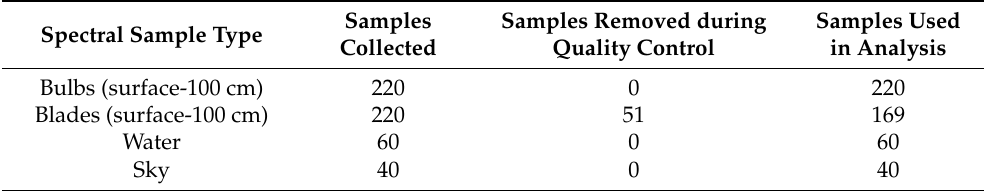
Table 2. Total number of each class of spectra before and after quality control was performed.